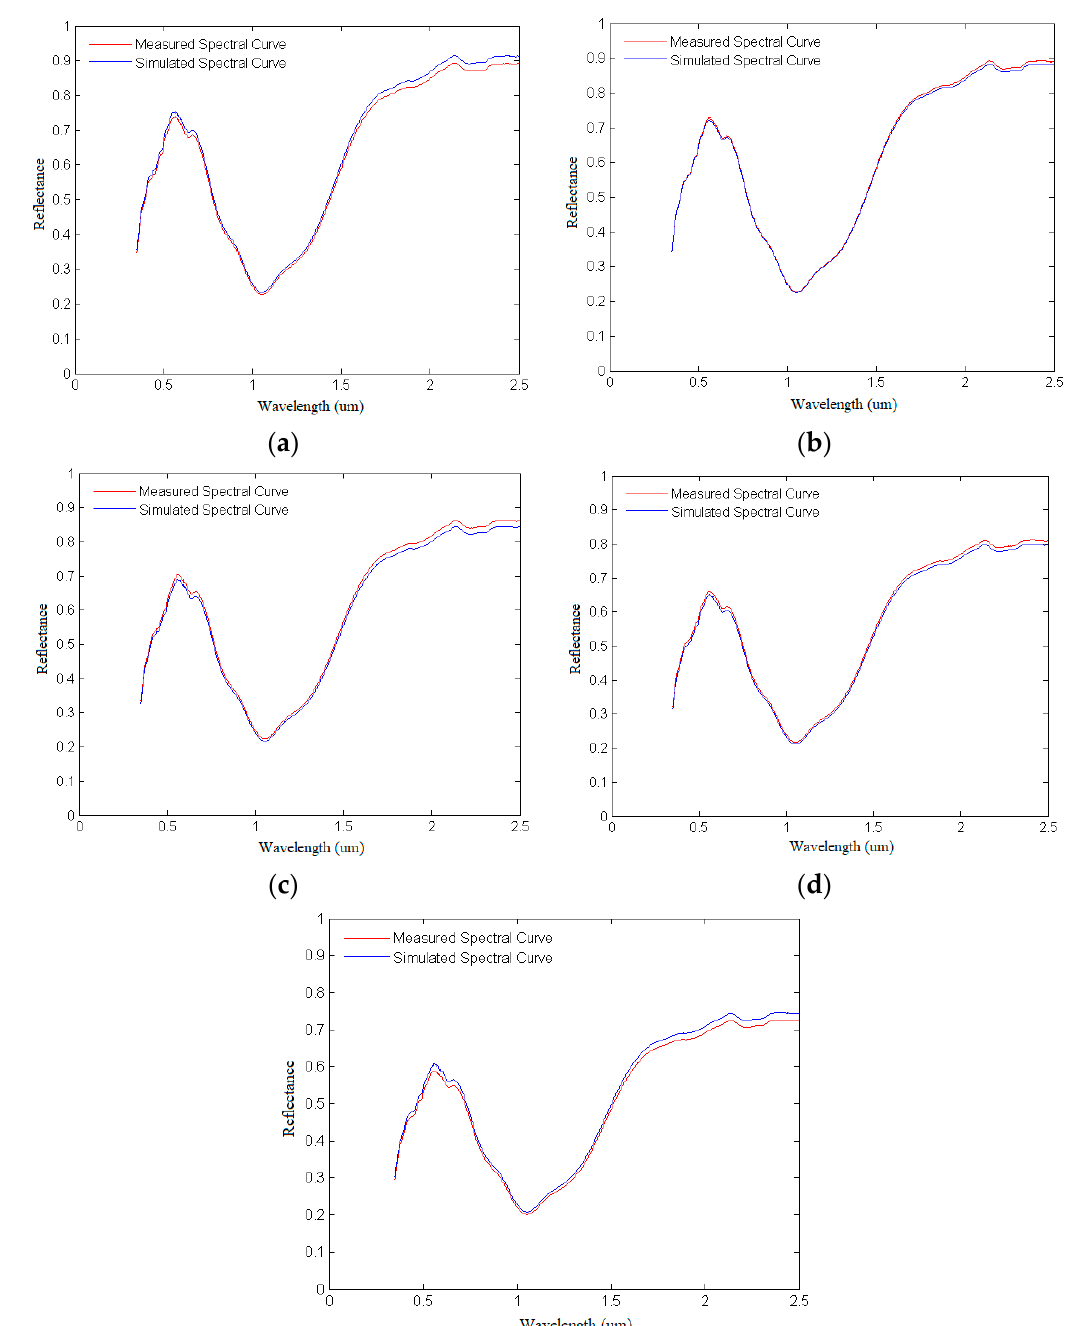
Figure 11. Comparison of the simulated and measured spectra of olivine at 20 ° ( a ), 30° ( b ), 40° ( c ), 50° ( d ), and 60° ( e ). To further quantitatively analyze the dynamics of reflectance with different incidence angles between the simulated spectrum and the measured spectrum, the characteristic wavelengths located at 0.57 µm and 2.15 µm are selected. The comparison results are shown in Figure 12, where the reflectance of olivine at characteristic wavelengths of 0.57 µm and 2.15 µm with an incidence angle of 0° and azimuth of 210° is compared with that of the simulated spectra. The simulated spectrum well reflects the change in the reflec- tance as a function of angle, indicating that the photometric parameters of olivine obtained by optimized retrieval are more authentic.